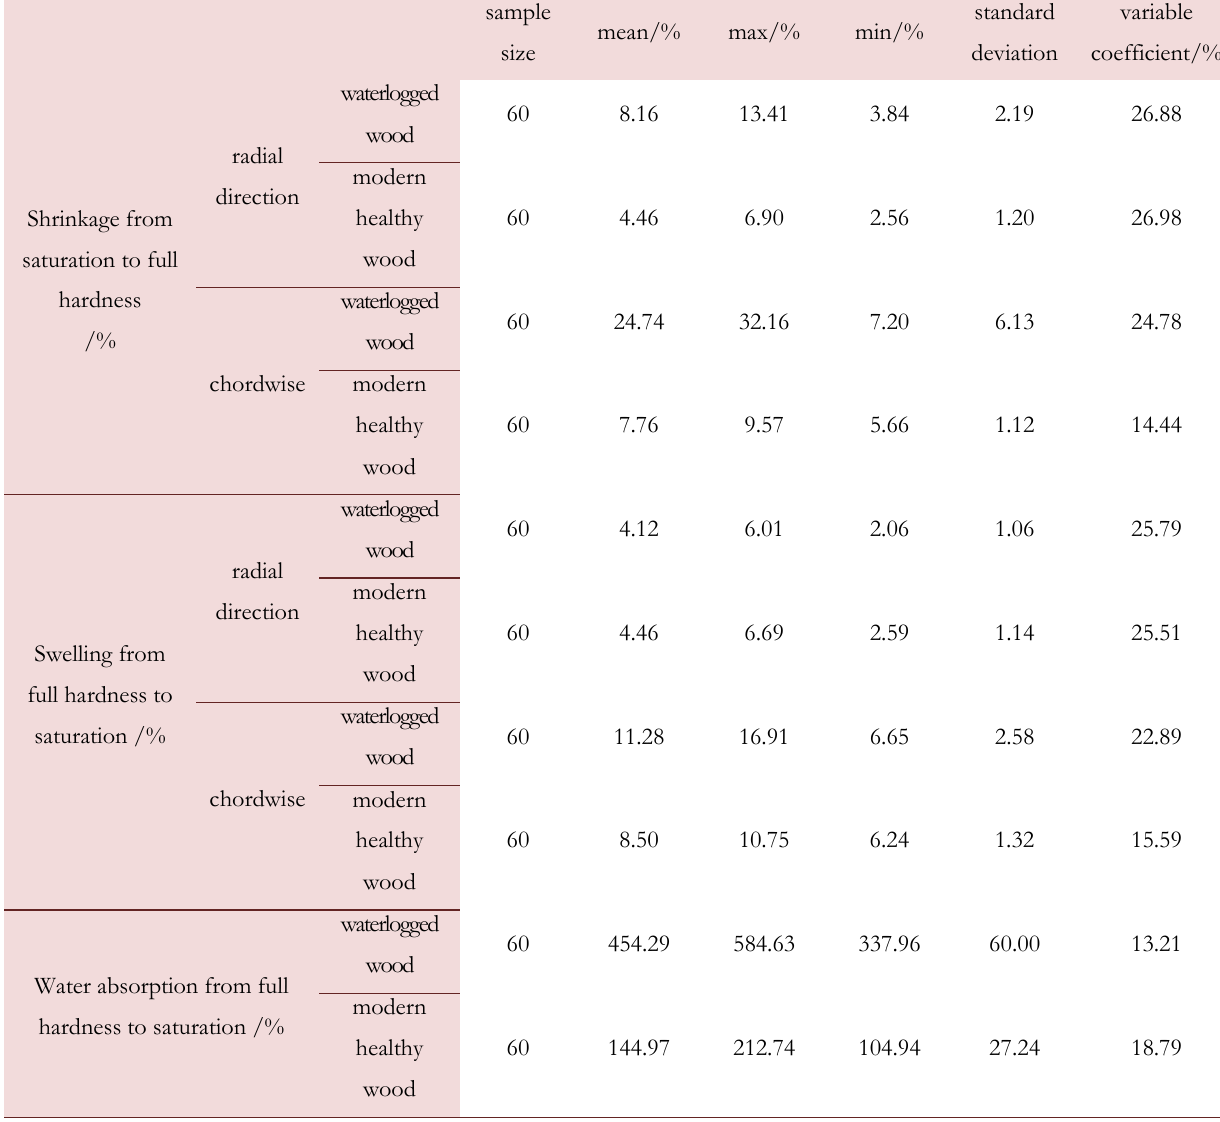
Table 2: Shrinkage, swelling and water absorption of Pinus yunnanensis ancient wood and healthy